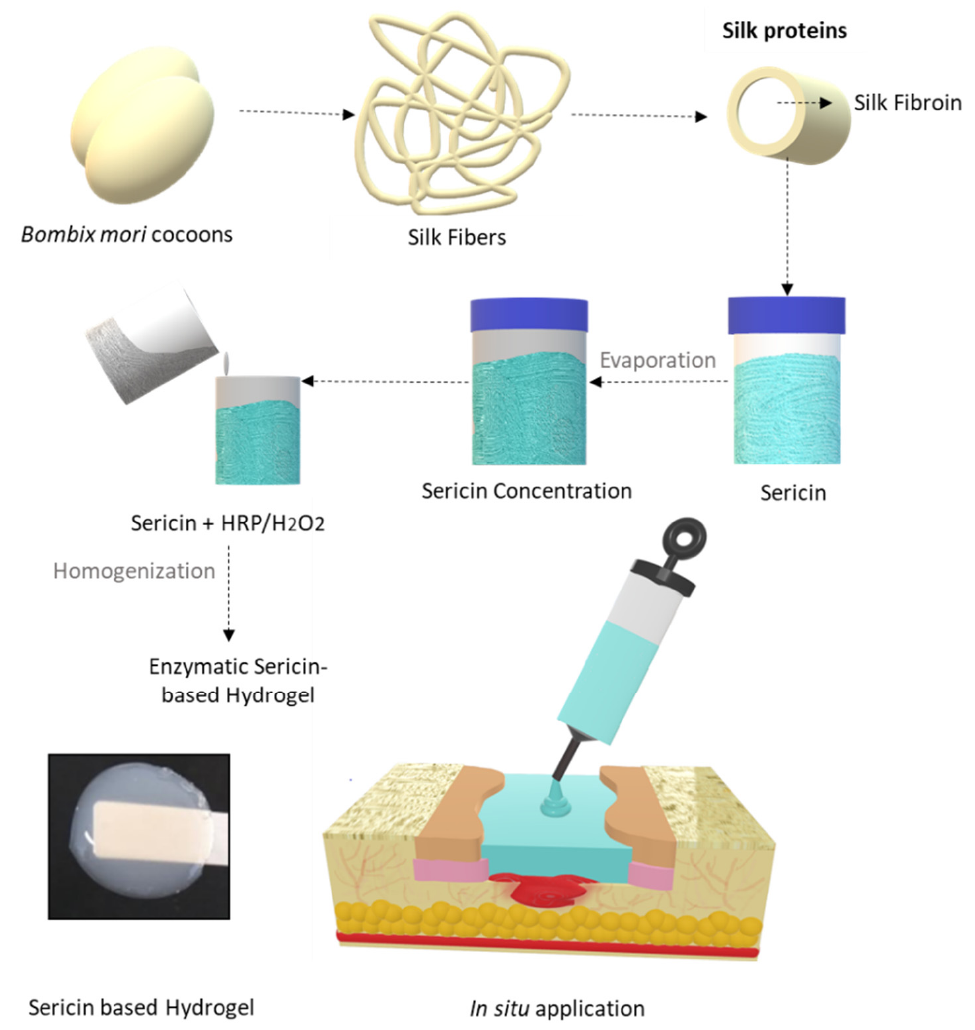
Figure 1. Schematic illustration of the procedure for preparing the SSH and application of the sericin-based HRP-mediated hydrogel crosslinking in a clinical setting.